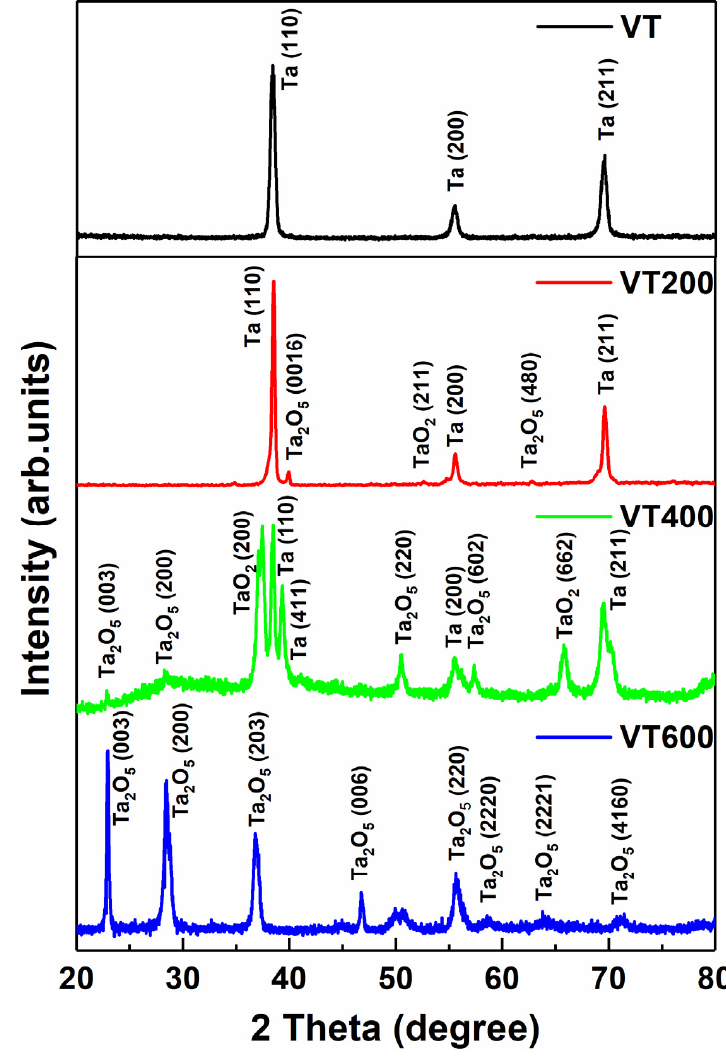
Figure 1. The XRD diffraction patterns of the surface of tantalum coatings thermal treated at different temperatures.